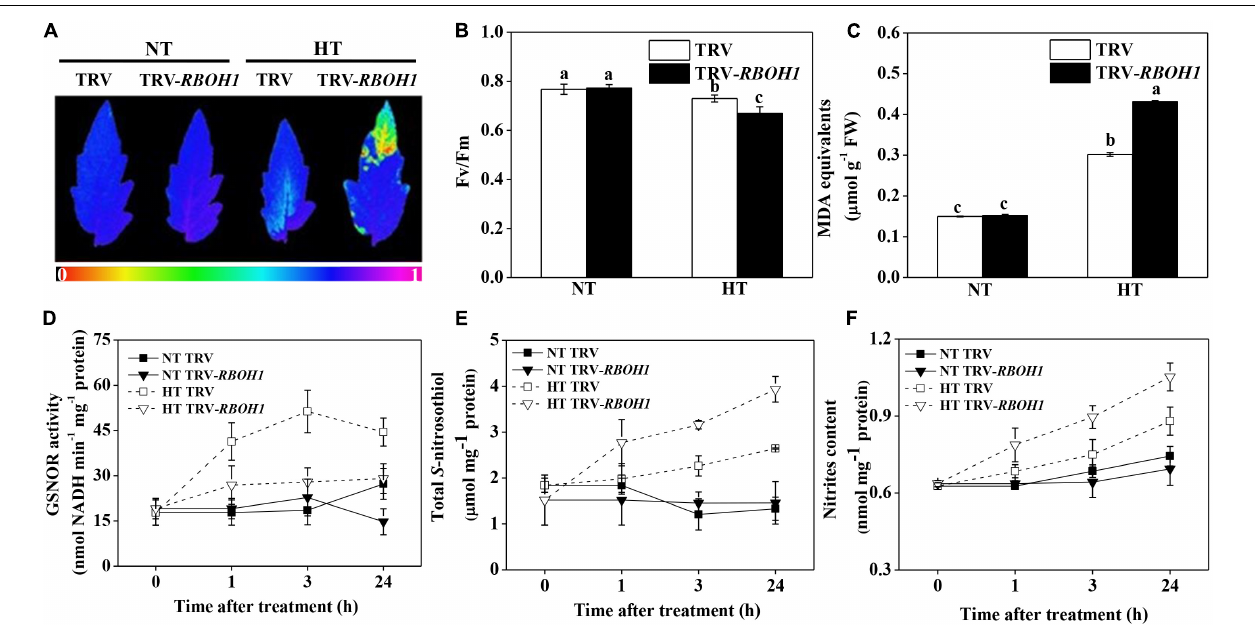
FIGURE 6 | Silencing of SlRBOH1 compromised thermotolerance and impaired SNO metabolism. (A) Images of the maximum quantum yield (Fv/Fm) of leaves after exposure to high temperature (42 ◦ C/38 ◦ C) or normal temperature (21 ◦ C/16 ◦ C). The pseudocolor scale at the bottom of the image ranges from 0 (black) to 1 (purple). (B,C) Fv/Fm values and malondialdehyde (MDA) content in leaves after exposure to heat stress; (D–F) Enzymatic activity of GSNOR, total S -nitrosothiol (SNO) content and nitrites content after heat stress. Data are means of five replicates ( ± SD). Means denoted by the same letter did not significantly differ at P < 0.05, according to Tukey’s test. NT, normal temperature; HT, high temperature.